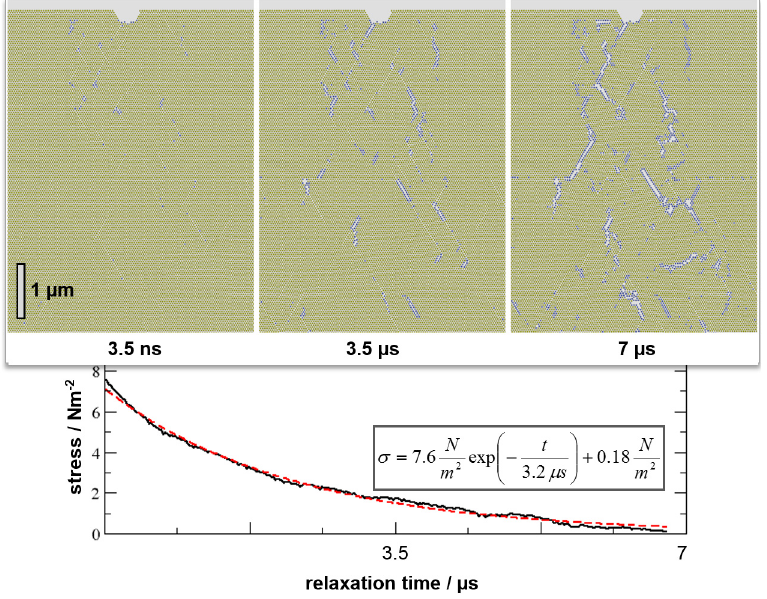
Fig 4. Relaxation of the scale-up model after loading and holding 5% strain along the horizontal direction. The initially elastically deformed model evolves in favor of a heterogeneous fracture/plastic deformation pattern and exponential decay of the stress profile is observed (fitted curve shown in red). Note that instead of a single fracture line (which would imply material failure) we observe a non-percolating pattern of a large number of